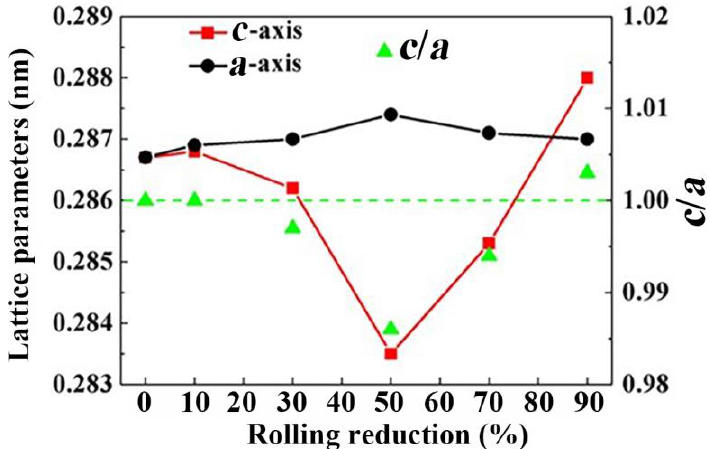
Figure 8. Lattice parameters and c/a ratios of ferrites in SK85 steel at different rolling reductions.